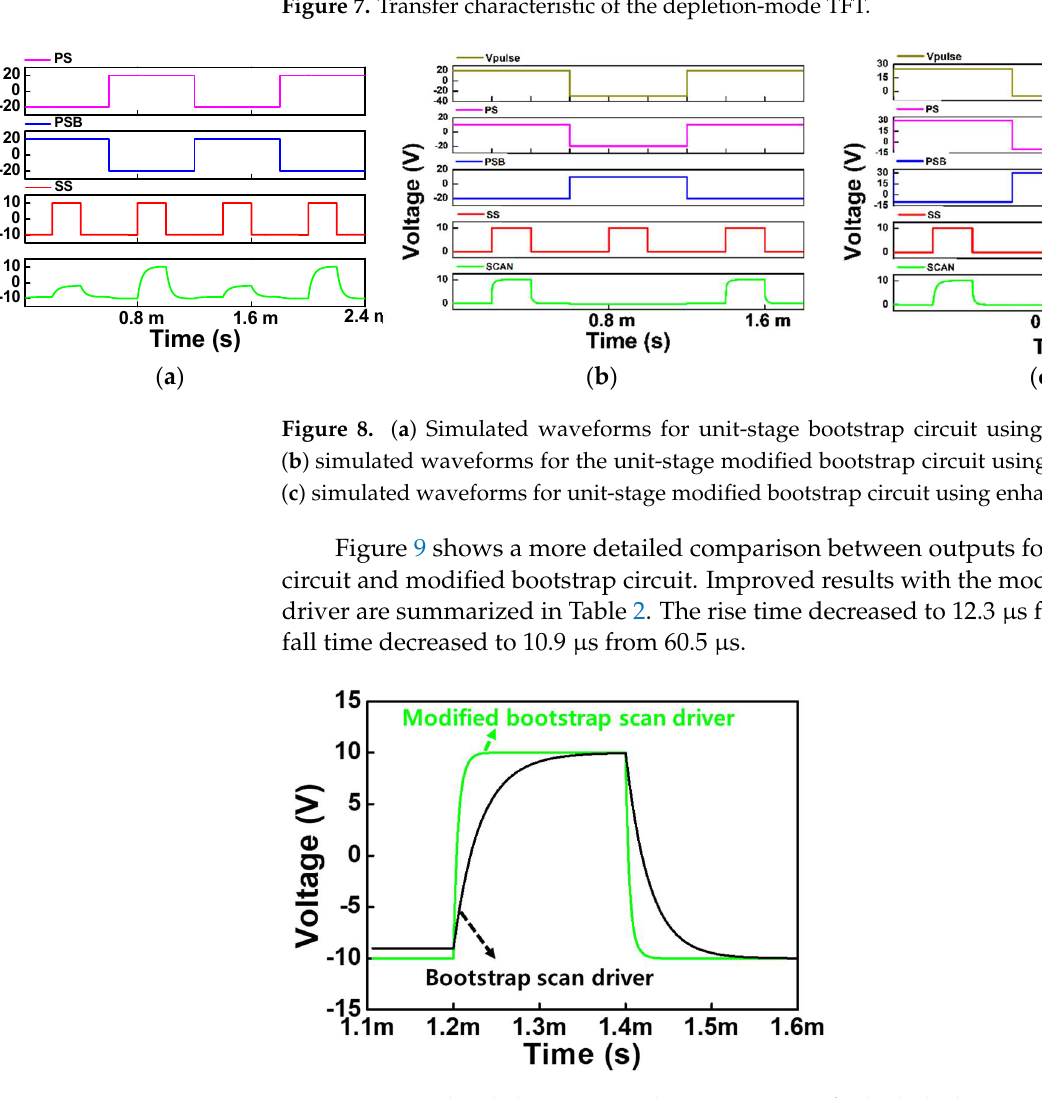
Figure 9. More detailed comparison between outputs for both the bootstrap circuit and modified bootstrap circuit.